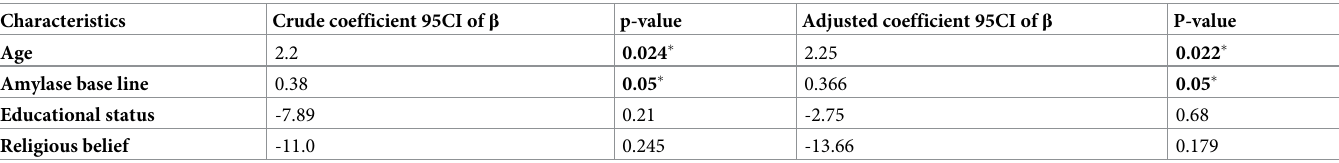
Table 6. Multiple linear regression between serum amylase at test of cure with different factor variables.